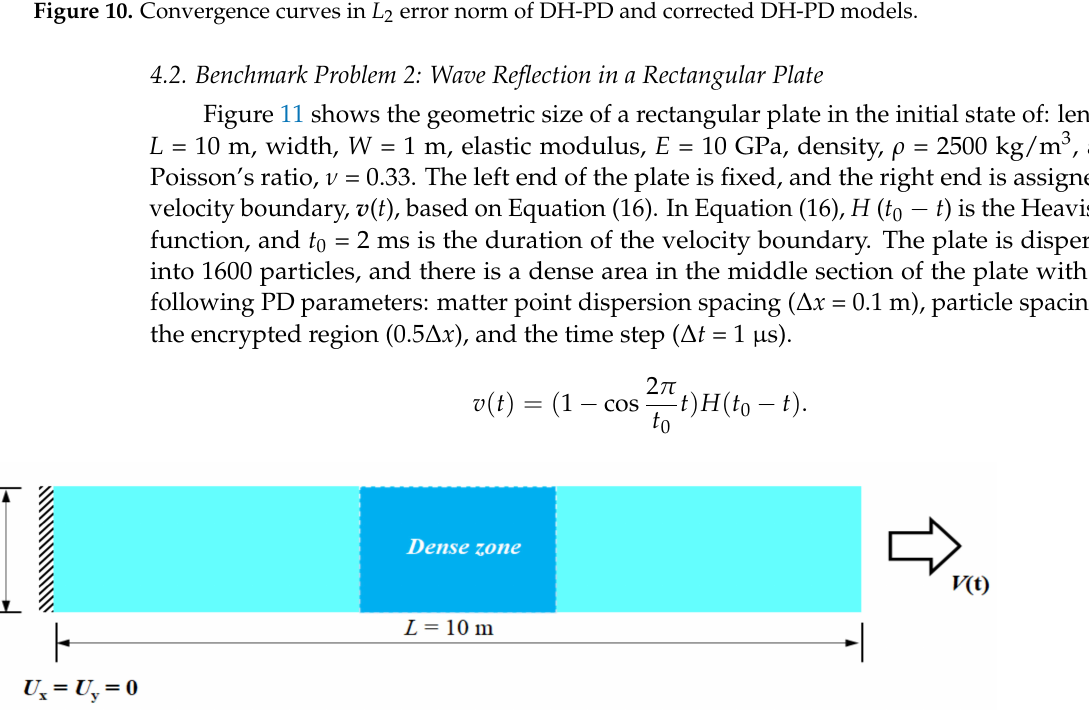
Figure 11. Geometry of the plate in the initial